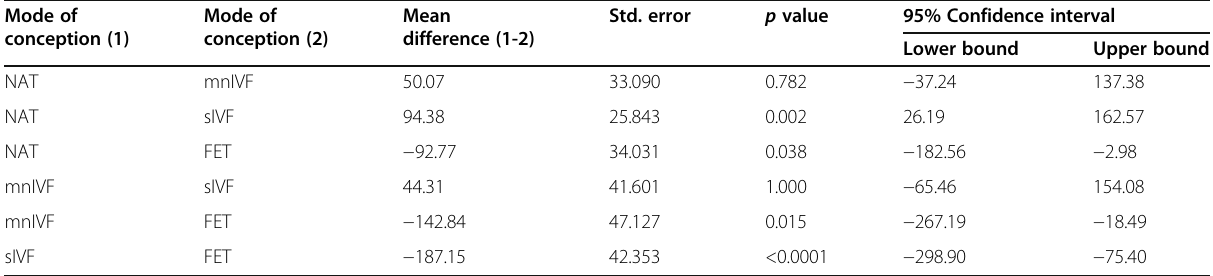
Table 4 Multiple comparisons of birth weight between different modes of conception Mode of conception